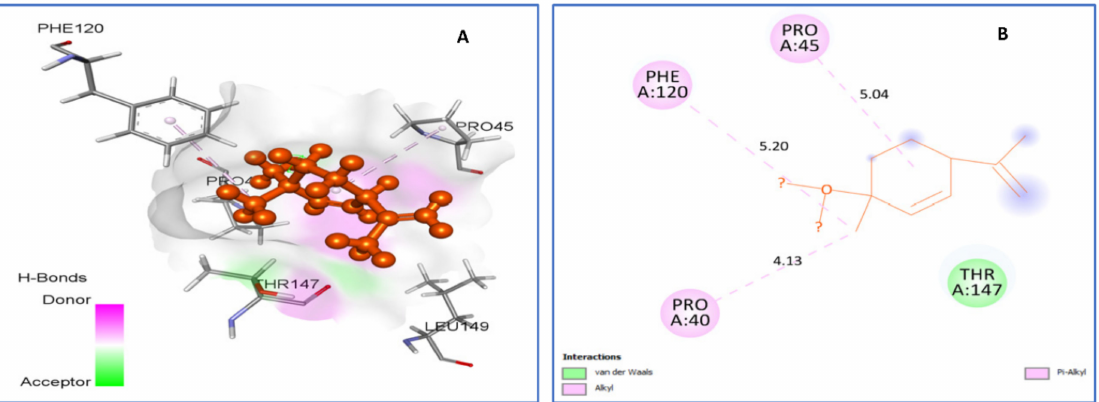
Figure 7. Two-dimensional (2D) and three-dimensional (3D) residual interactions network of trans - p - mentha-2.8-dien-1-ol ( A , B ) with the active site of Human peroxiredoxin 5 (PDB ID: 1HD2)